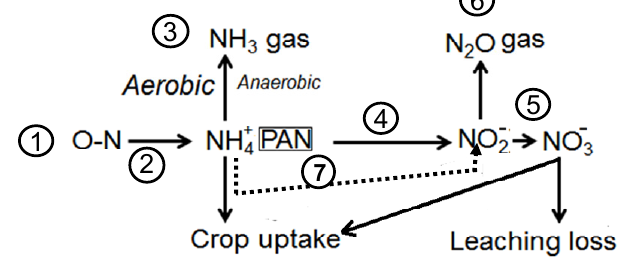
Figure 1. Biotransformation of organic nitrogen (O-N) in manure. (1) Decay of dead plants and animals release amino acids and proteins; (2) Ammonification of O-N by Saprotrophs, resulting in formation of NH 4+ (in acidic pH); (3) In aerobic environment the pH is basic, thus NH 4 + is converted into NH 3 gas that enters the atmosphere. In anaerobic process,